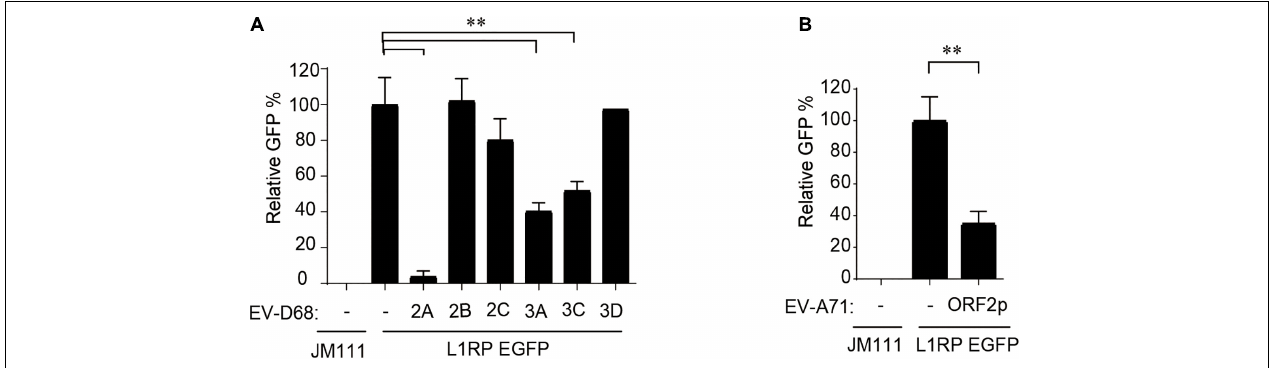
FIGURE 2 | Non-structural proteins of enterovirus impact on LINE-1 retrotransposition. (A,B) Empty vector VR1012 or EV-D68 2A, 2B, 2C, 3A, 3C, 3D, EV-ORF2p-expressing plasmids were co-transfected into HEK293T cells with L1RP EGFP plasmids. JM111 was used as a negative control for the cytometry assay. The bar represents retrotransposition efficiency, with the VR1012-transfected sample set to 100%. The asterisks indicate statistically significant differences between groups by Unpaired Student’s t -test ( p < 0.01). All experiments in this figure were performed in triplicate, and each error bar indicates the SD of three replicates in one